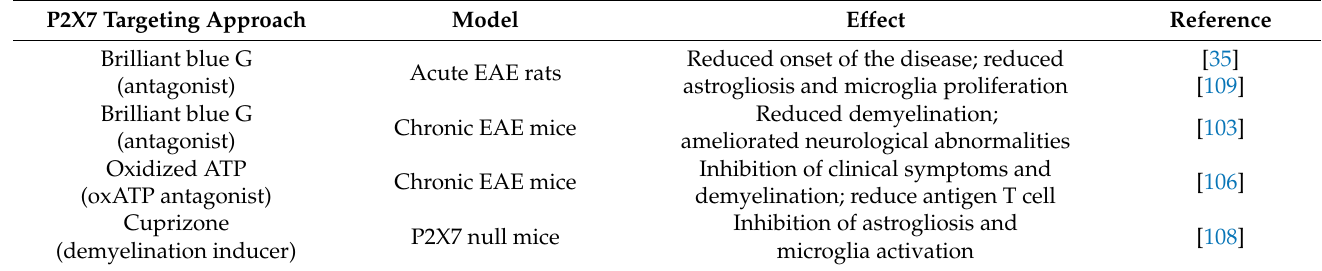
Table 1. Functional role of P2X7R during MS; results from experimental animal